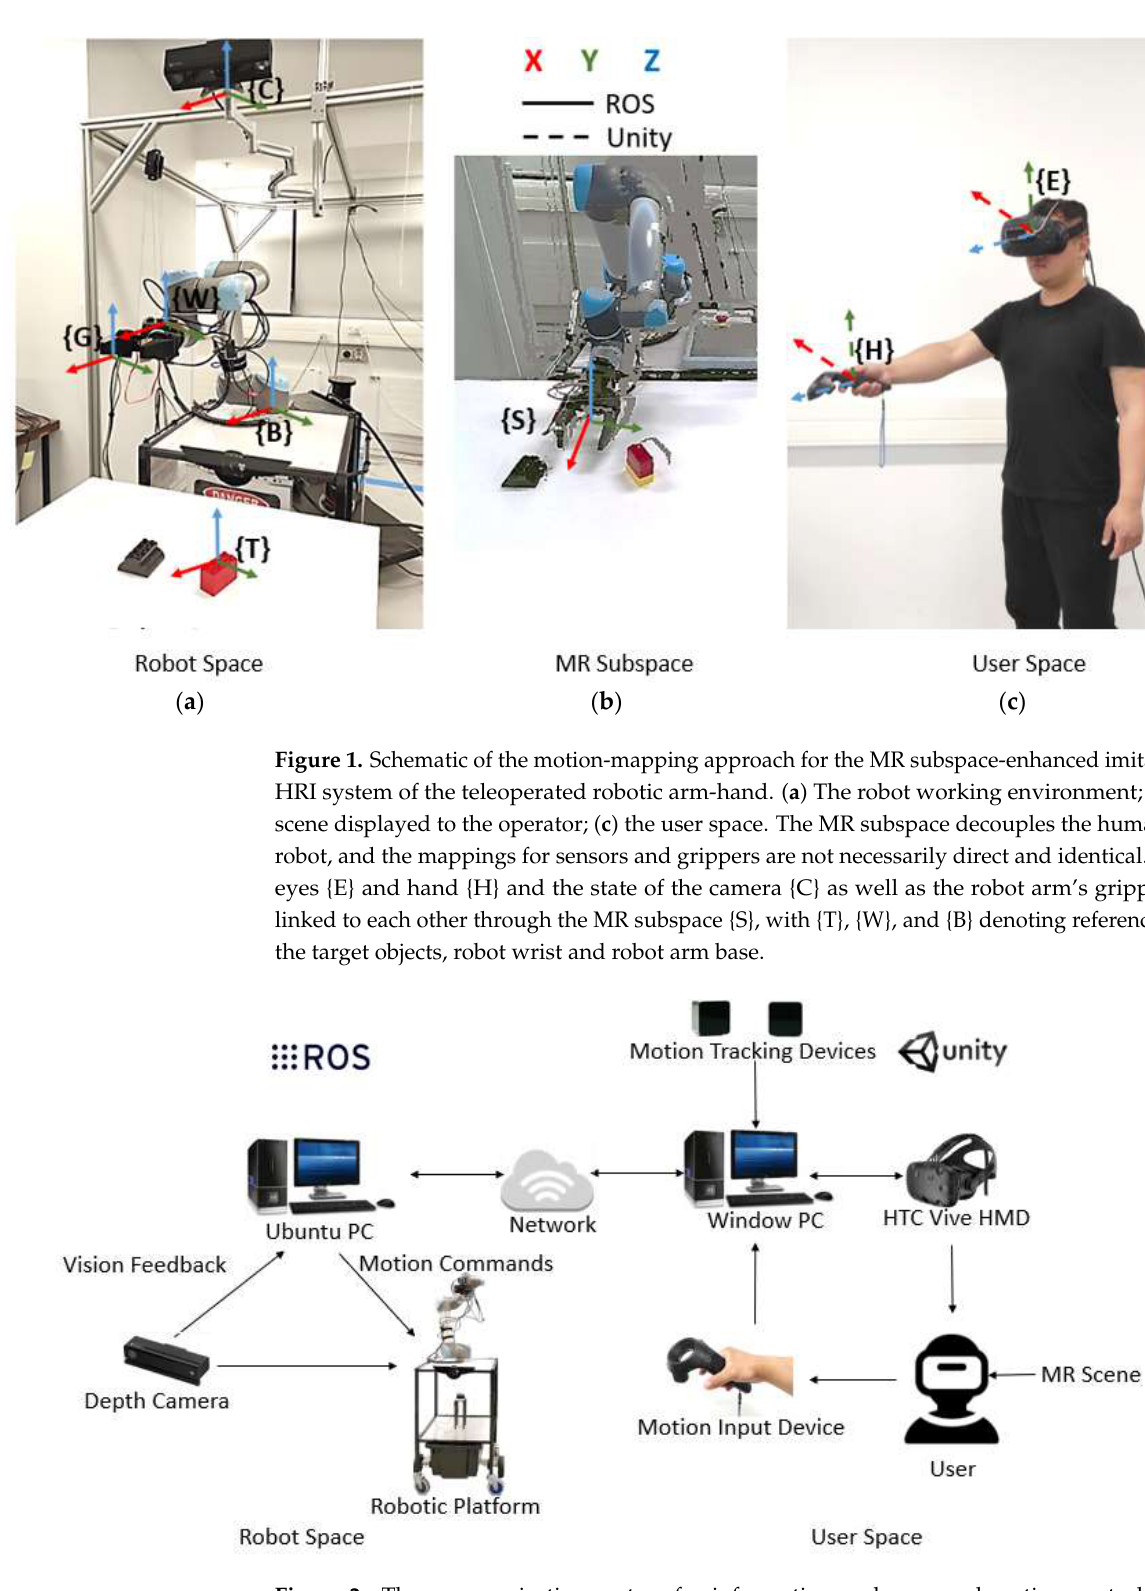
Figure 2. The communication system for information exchange and motion control of the MR subspace-enhanced imitation-based HRI of the teleoperated robotic arm-hand system.